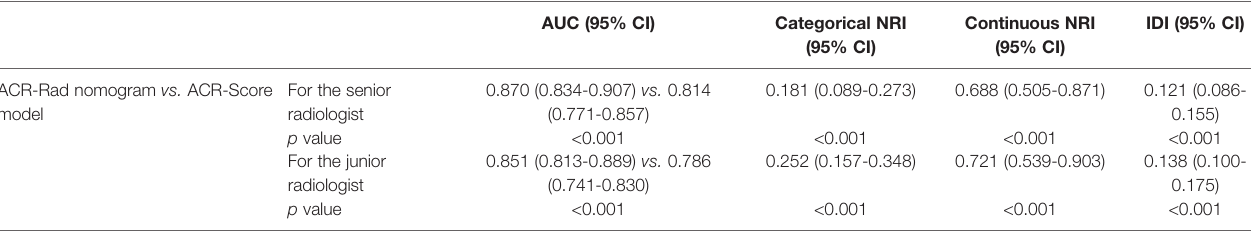
TABLE 4 | Performance of the ACR-Rad nomogram for predicting malignant thyroid nodules with interpretations from the senior and junior